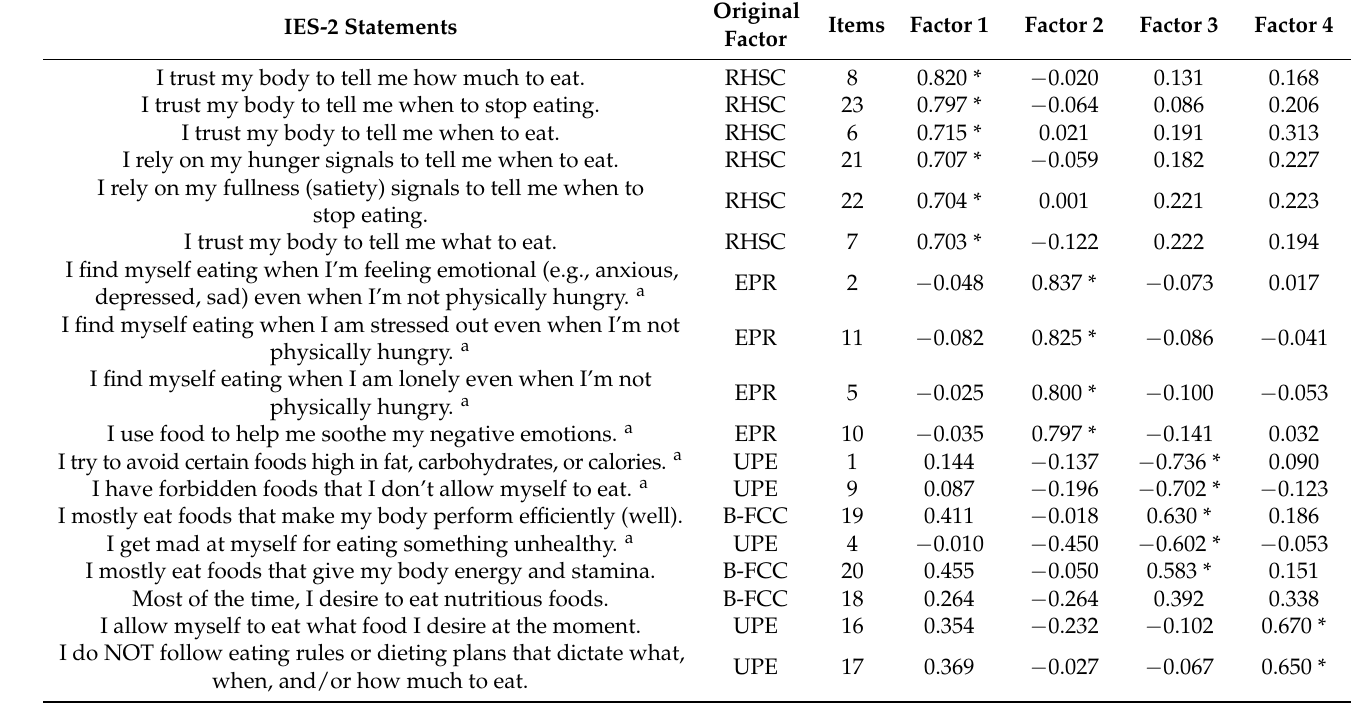
Table 2. Component loadings for IES-2